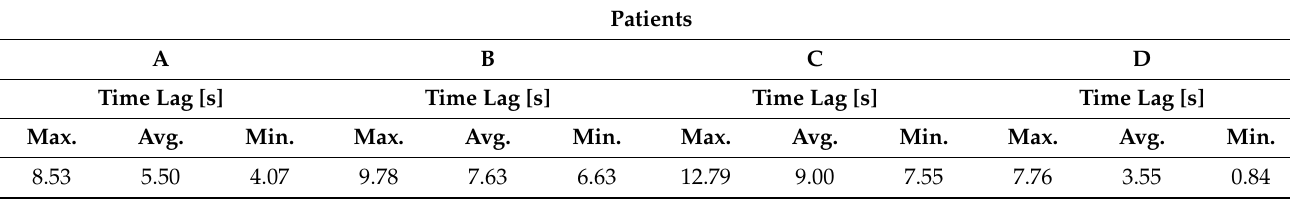
Table 4. Results of time lags in the preliminary indoor